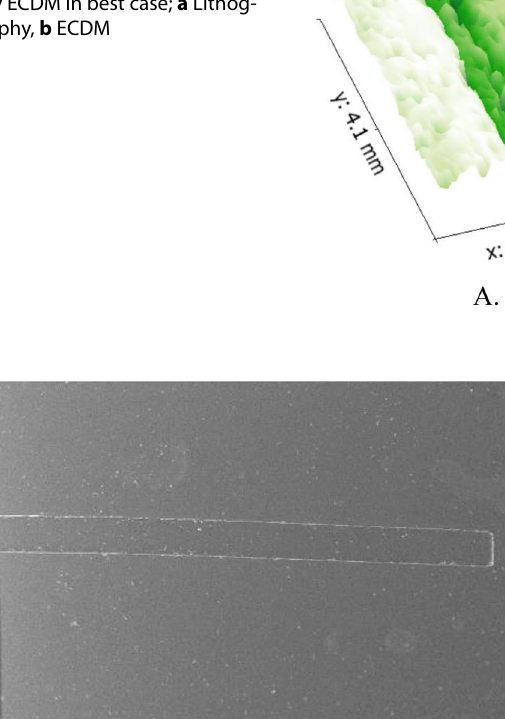
Fig. 15 Comparison of micro- channel profile created by lithography with that created by ECDM in best case; a Lithog- raphy, b ECDM